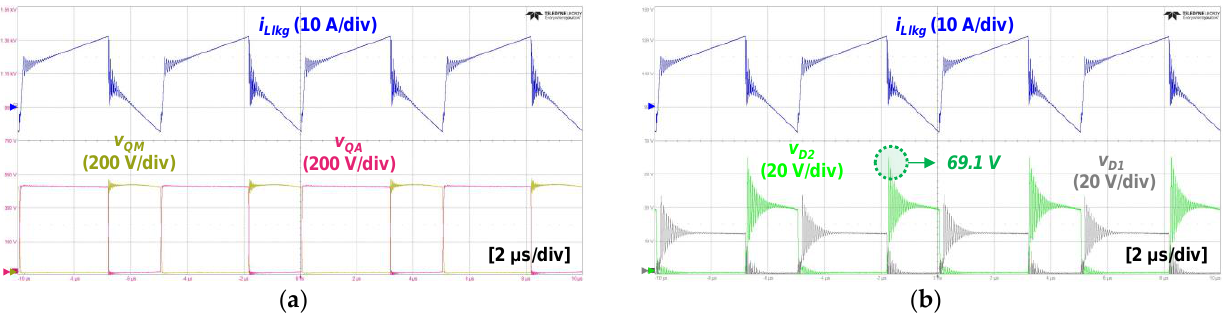
Figure 15. Key experimental waveforms at 200 V input and 100% load conditions: ( a ) Primary side key experimental waveforms. ( b ) Secondary side key experimental waveforms.